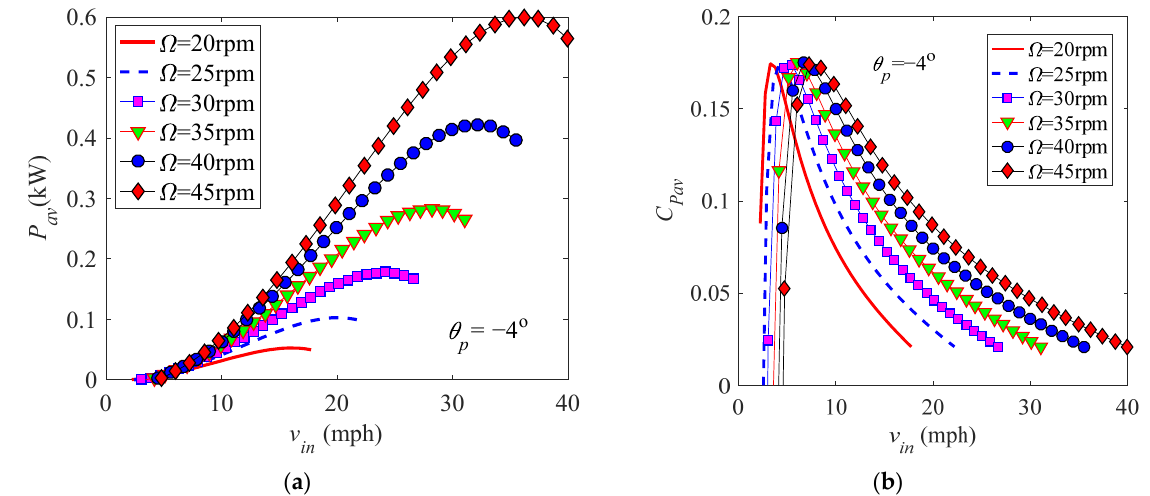
Figure 16. Variations of ( a ) the power and ( b ) power coefficient with the incoming wind speed for the fixed θ p = − 4°.